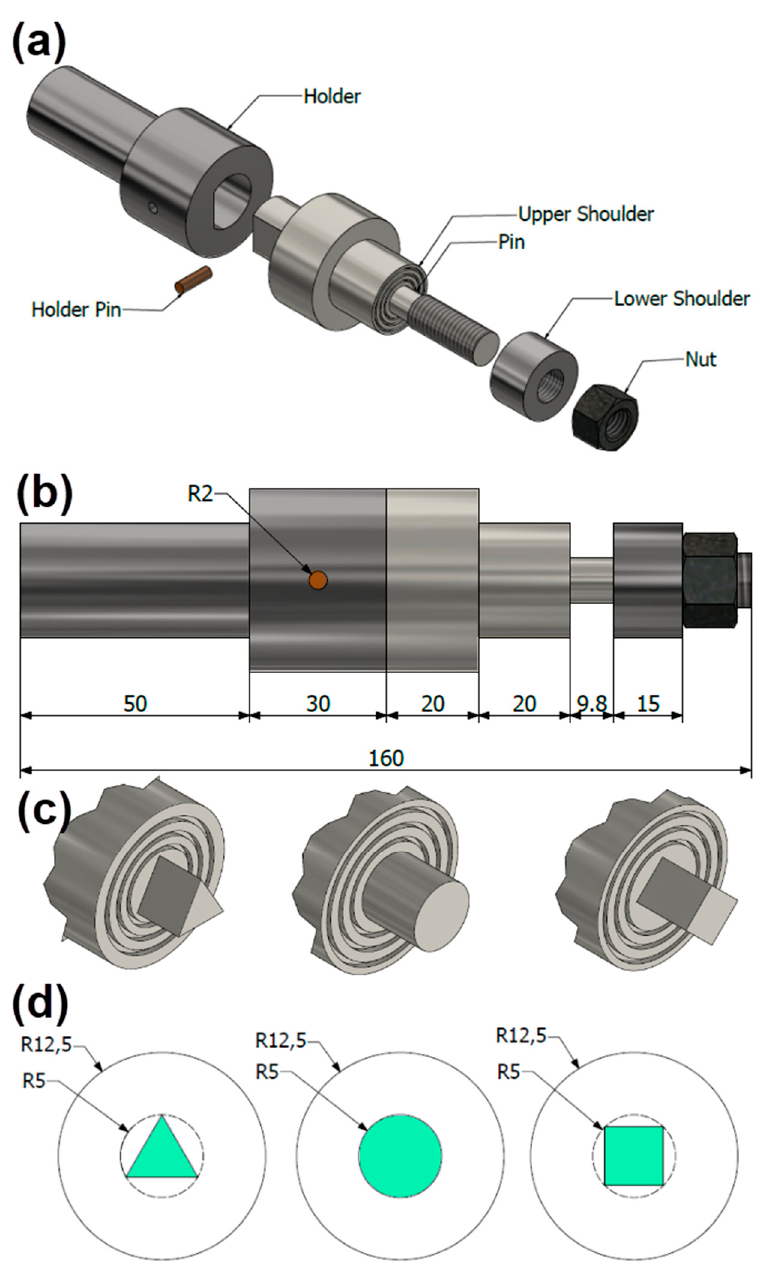
Figure 2. Dimension of BT assembly (all dimensions in mm). ( a ) Exploded assembly of BT parts, ( b ) Dimensions of BT, ( c ) 3D view of used BT pin profiles, and ( d ) dimension of BT pins and shoulders. The BT-FSW was carried out at various travel speeds “Ts” of 200, 400, 600, 800, and 1000 mm/min using the three different pin geometries (Cy, Sq, and Tr), and constant rotation speed “Rs” of 600 rpm at 0 tilt angle. Table 3 summarizes the BT-FSW process parameters. BT-FSW similar lap joints were carried out using the FSW machine